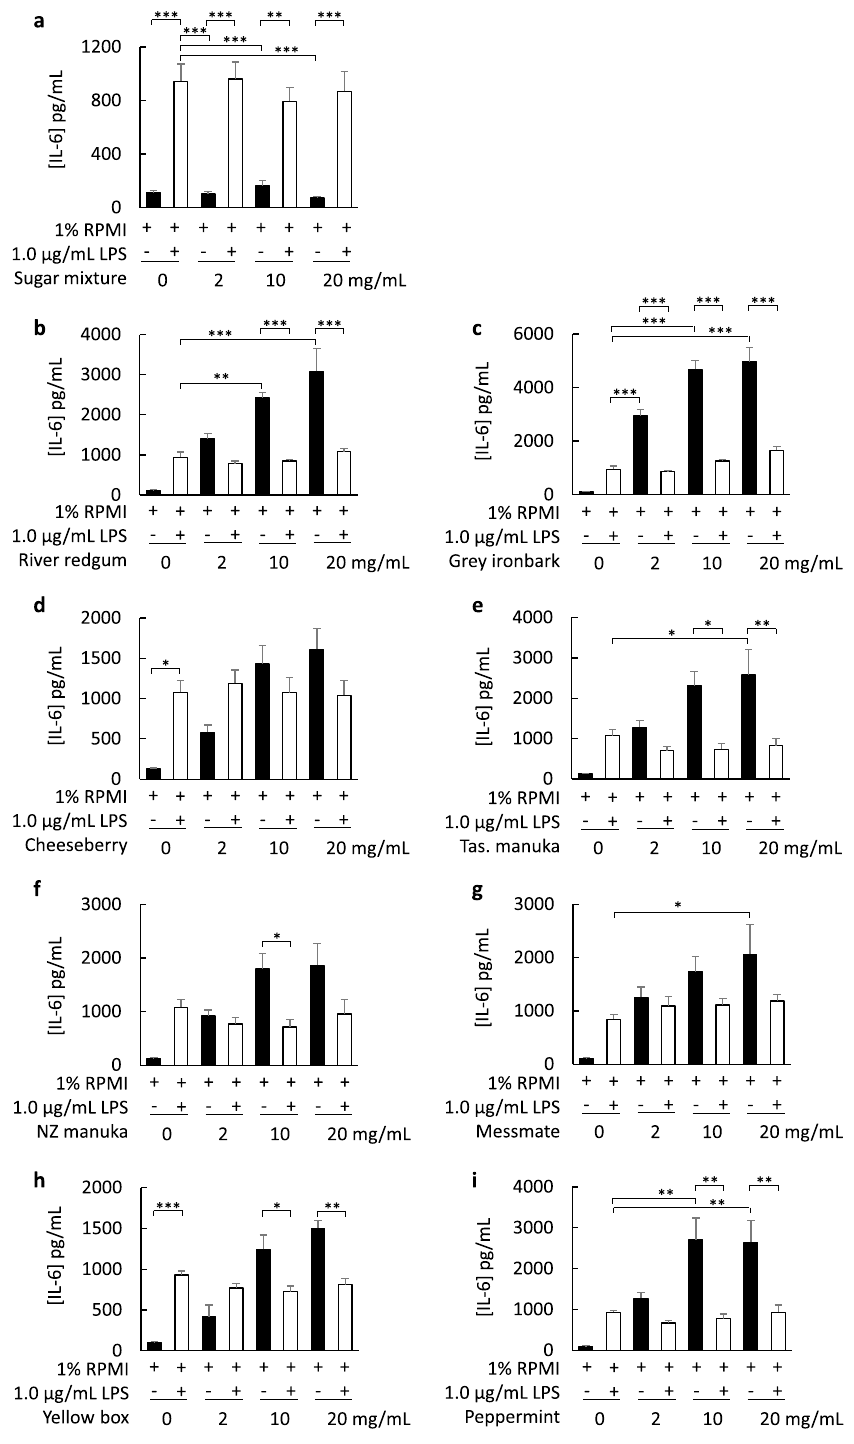
Figure 3. Secretion of interleukin-6 (IL-6) by human cultured neonatal fibroblasts exposed to a sugar mixture ( a ) or honey sample ( b – i ), in the absence or presence of 1.0 µg/mL lipopolysaccharide (LPS), for 24 h. Samples include river red gum ( b ), grey ironbark ( c ), cheeseberry ( d ), Tasmanian manuka ( e ), New Zealand manuka ( f ), messmate ( g ), yellow box ( h ) and peppermint ( i ) honeys (2–20 mg/mL). Data are mean ± SEM, n = 3–4; * p < 0.05; ** p < 0.01; *** p < 0.001. Statistical analysis was performed using one-way